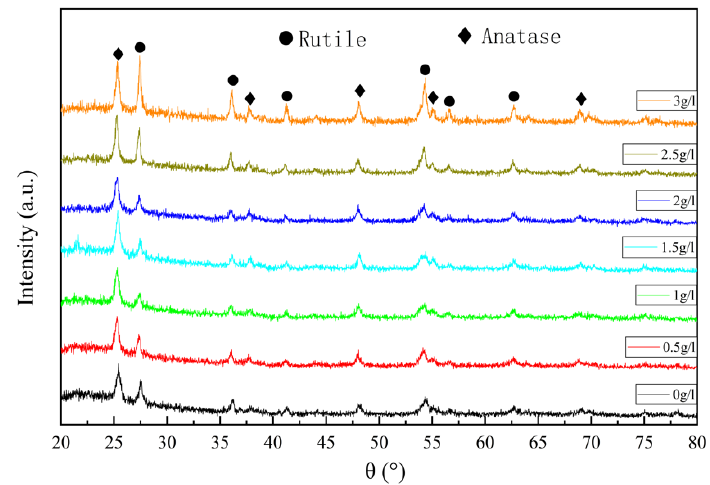
Figure 2. X-ray (XRD) pattern of the micro-arc oxidation film of TC4 titanium